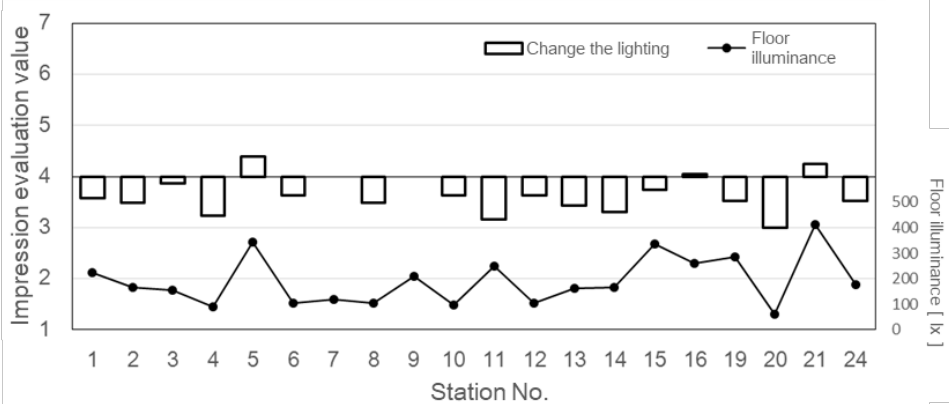
Figure 19. Results of the impression evaluation of ‘want to change the lighting’ and floor illumi- nance.